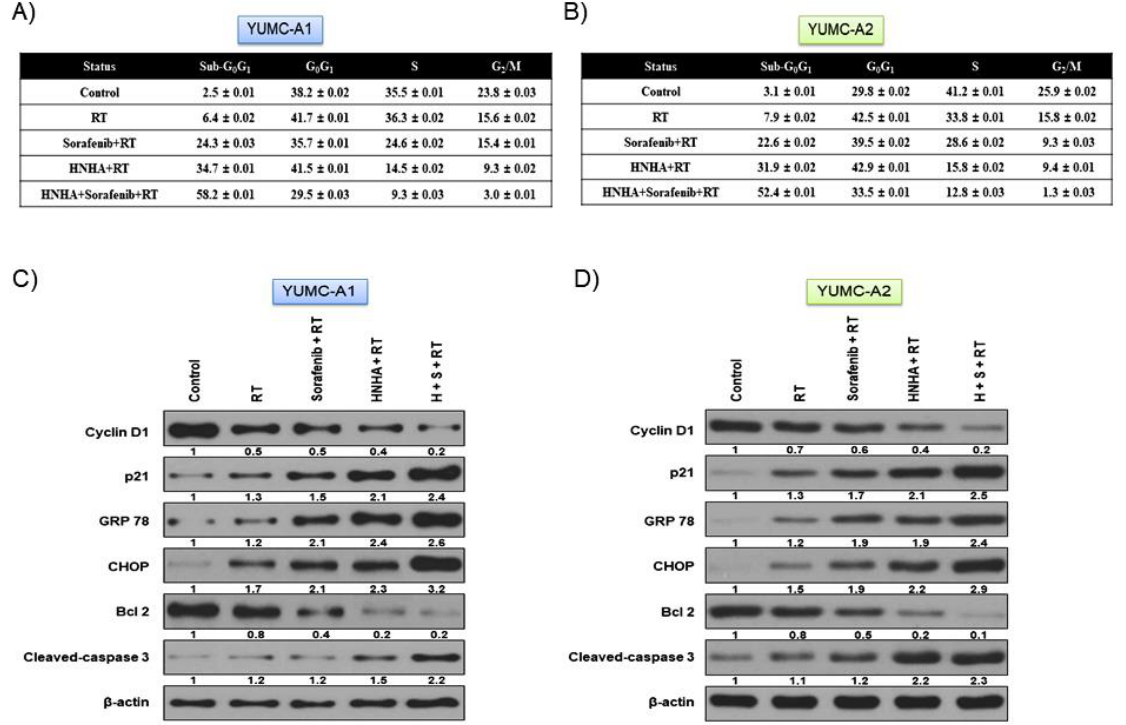
Figure 4. Cell cycle arrest and apoptosis analysis by quantitation of DNA content with propidium iodide and immunoblot analysis: ( A , B ) Cell cycle arrest and apoptosis were significantly induced by the combination of HNHA, sorafenib, and radiation in patient-derived ATC cell lines, YUMC-A1 and YUMC-A2. Cells were exposed to the indicated inhibitors, harvested, and stained with propidium iodide before analysis by flow cytometry and FlowJo v8; ( C , D ) Immunoblot analysis of the markers of cell cycle, apoptosis, anti-apoptosis, and ER stress on patient-derived ATC cell lines, YUMC-A1 and